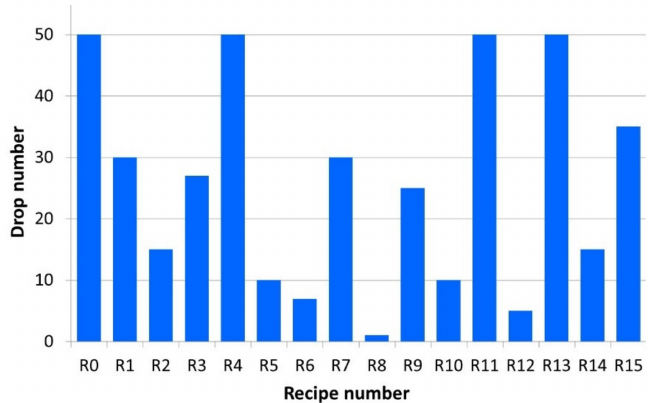
Figure 1. Drop test for the developed briquettes.